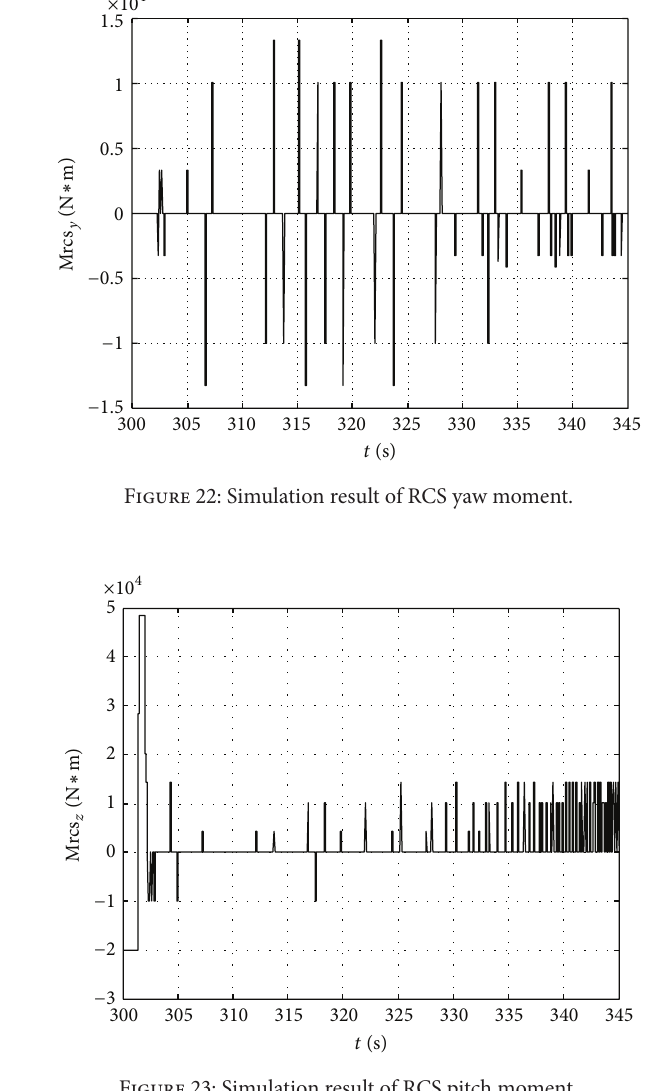
Figure 21: Simulation result of RCS roll moment.